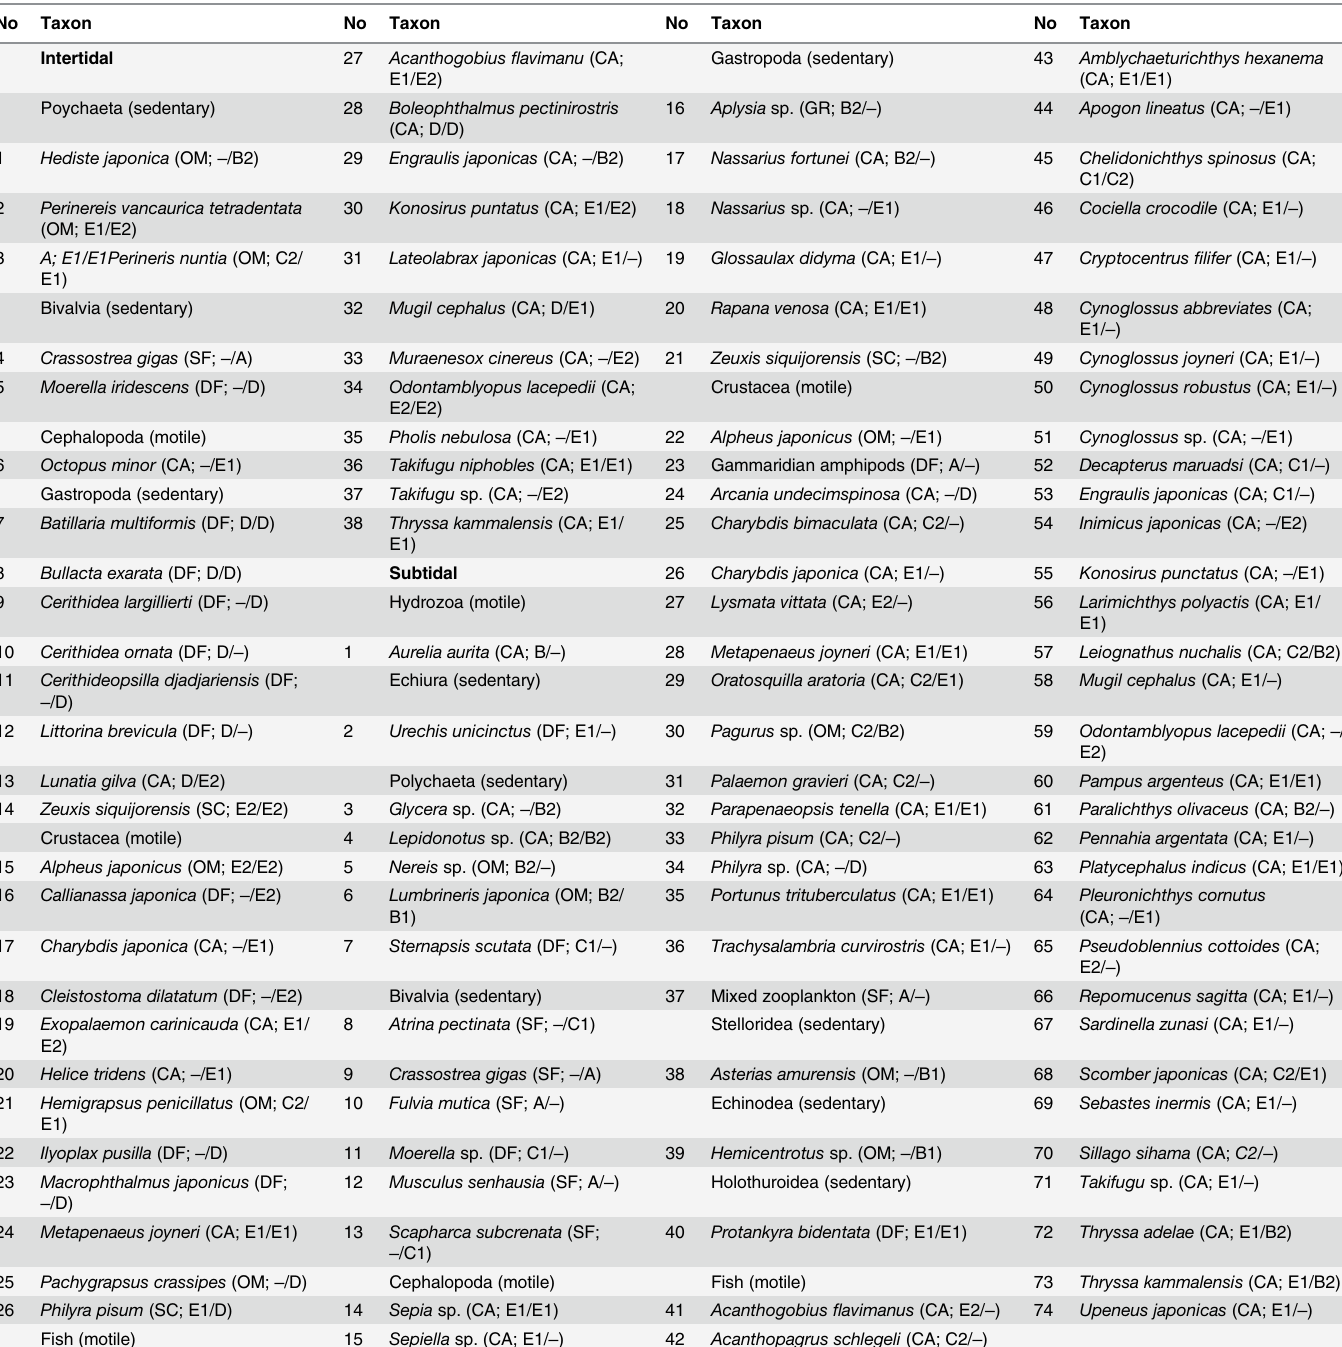
Table 1. List of intertidal and subtidal consumers whose isotope composition was analyzed in the present